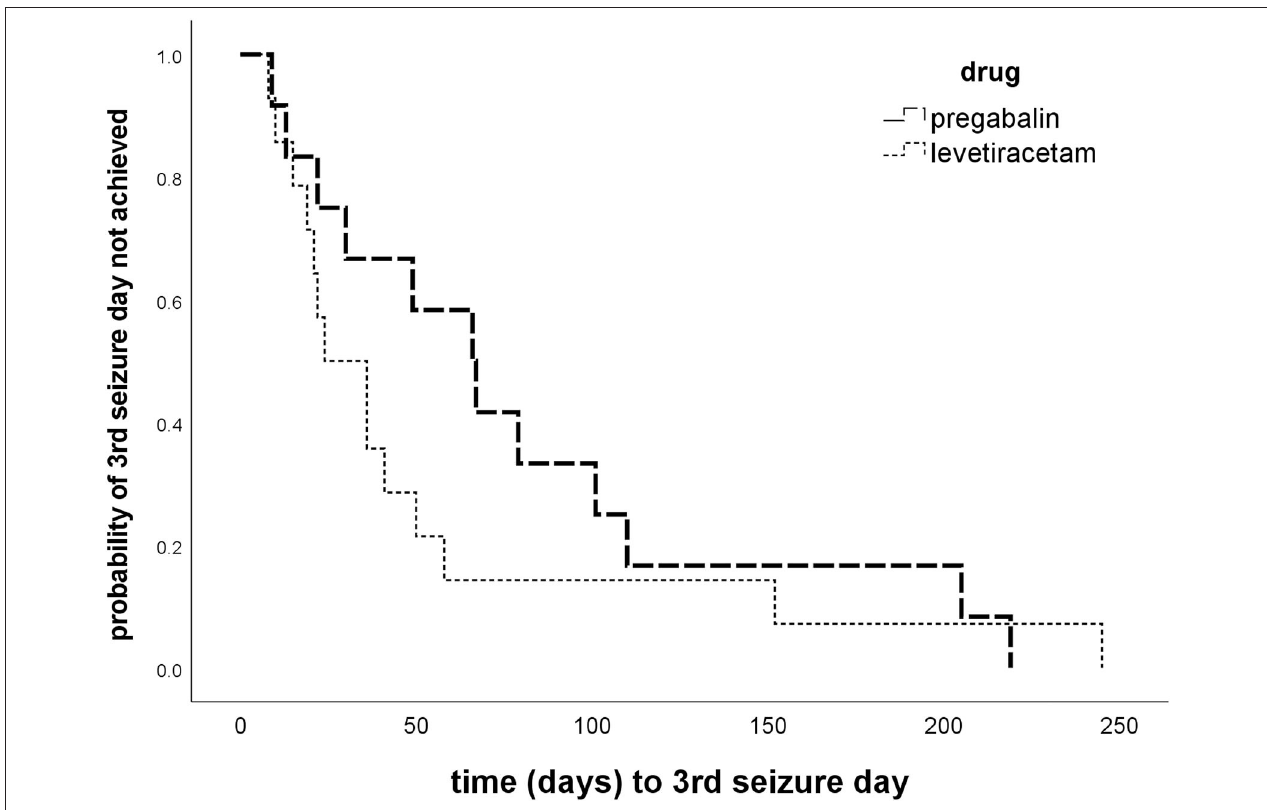
FIGURE 2 | Time to 3rd GTC seizure day. Kaplan–Meier plots of time (days) to 3rd generalized tonic–clonic seizure day in the treatment phase show no difference between the pregabalin BID and levetiracetam dose increase group ( p =